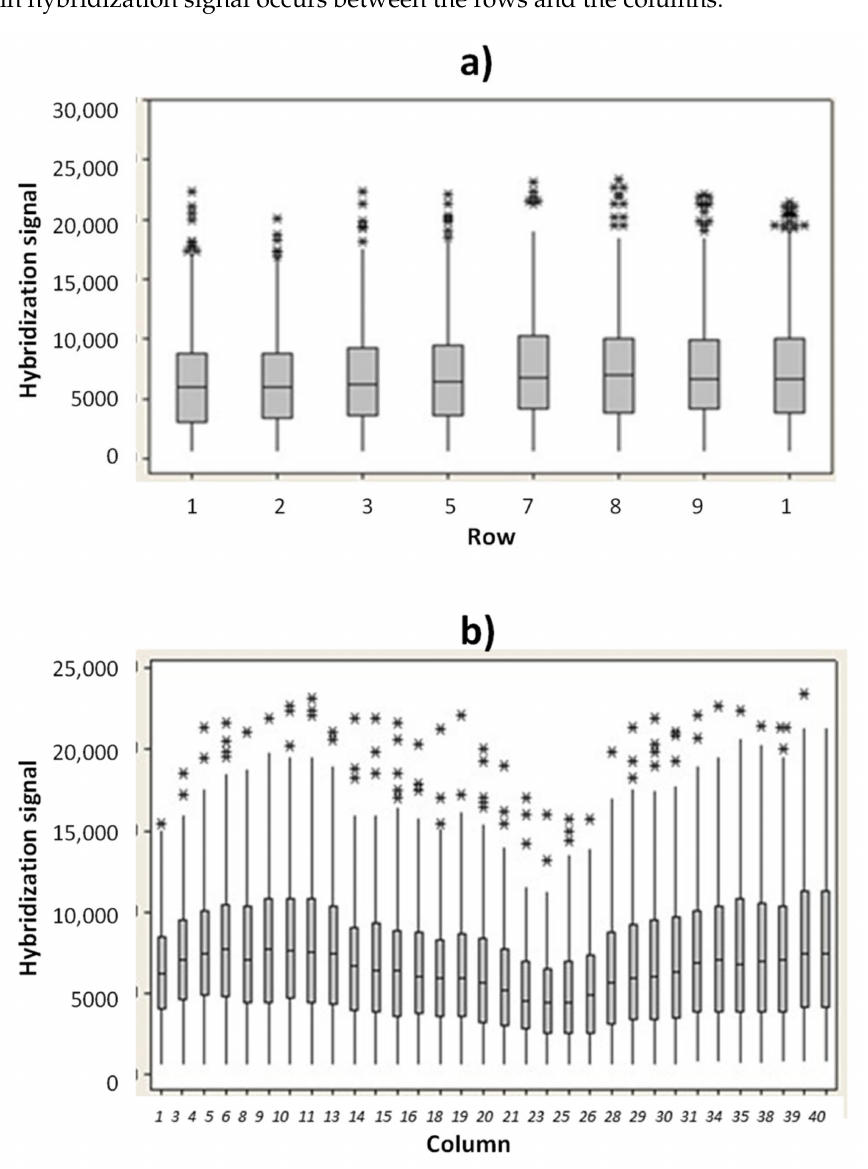
Figure 3. Hybridization signal of ST1 probe (acquisition time 15 ms) versus row ( a ) and versus column ( b ). (* outlier data).